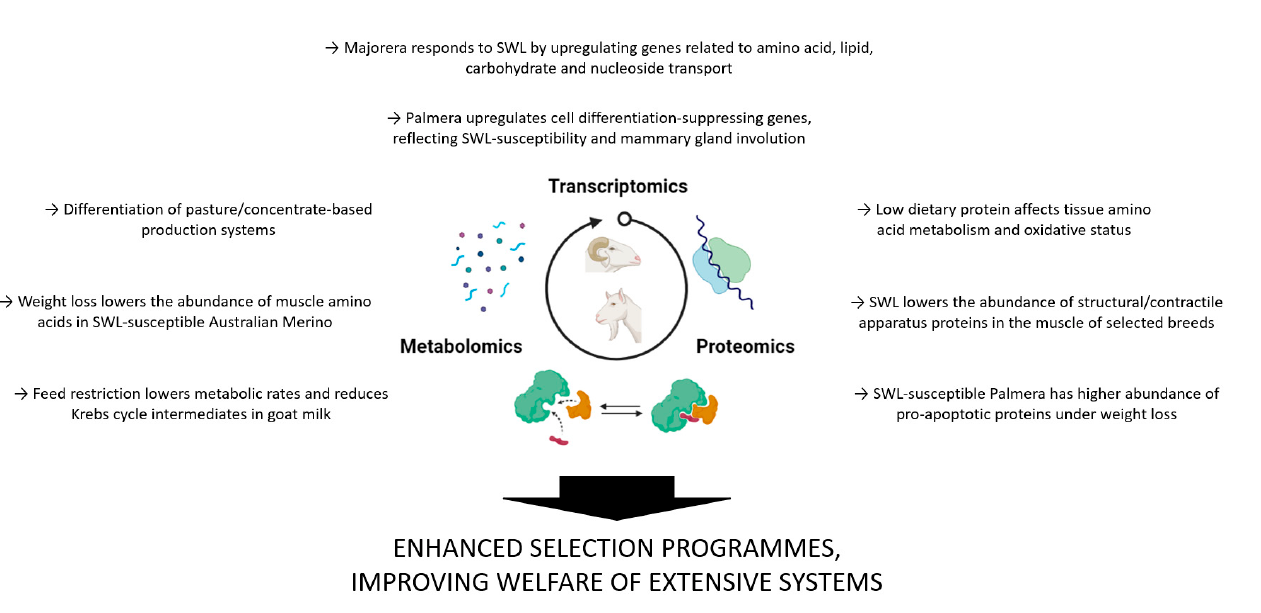
Figure 1. Omics information was obtained within the context of small-ruminant production systems, comparing dairy goat breeds (Majorera and Palmera) and meat-producing sheep (Australian Merino, Damara, and Dorper) under seasonal weight loss (SWL). Image created using biorender.com.